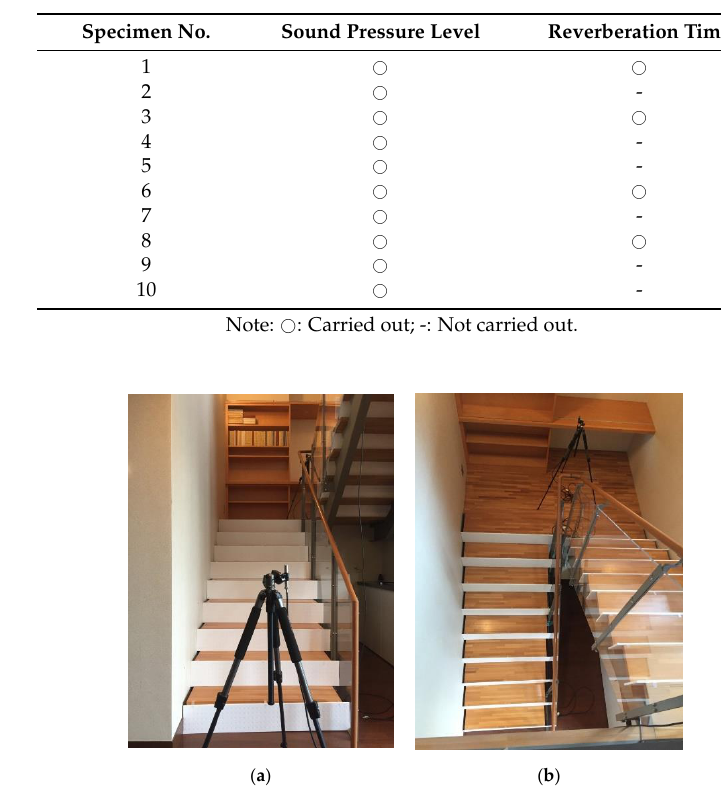
Figure 6. Sound absorption panel installation setup in the wall of landing. Figure 7. Sound absorption panel installation setup in the wall and ceiling of second floor. 3. Reduction Effect of Sound Pressure Level Figure 8 shows the difference in sound pressure levels due to variations in the sound source position, installation area, and installation position, given in Table 2, which uses “no